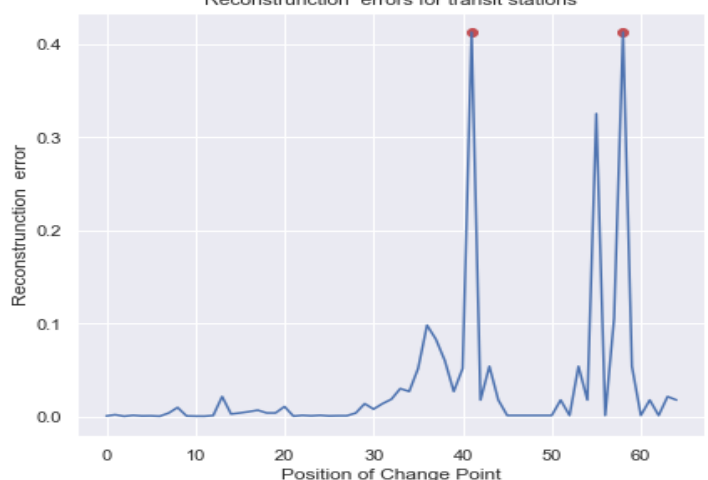
Figure 7. Reconstruction errors for transit